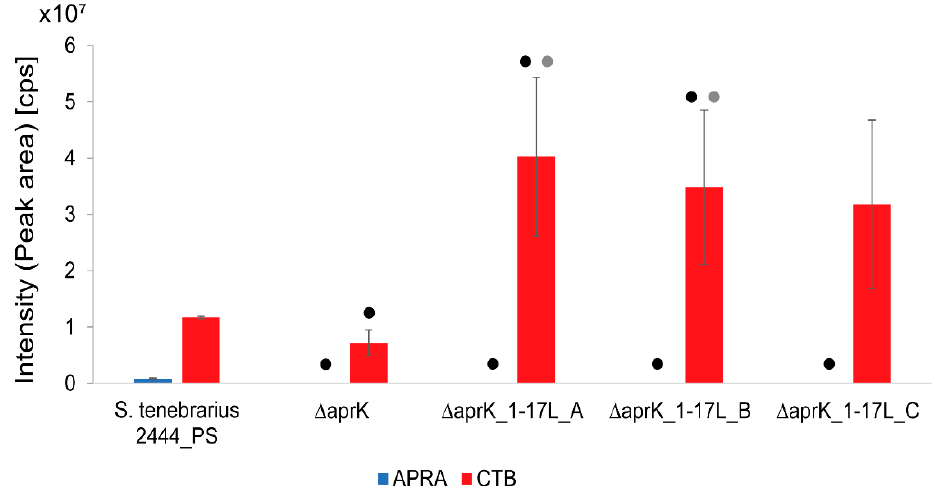
Figure 6. Apramycin (APRA) and carbamoyltobramycin (CTB) production in the Streptoalloteichus tenebrarius 2444 PS, the ∆ aprK mutant, and the ∆ aprK mutant containing an additional copy of the tobramycin BGC (triplicates for three isolates of ∆ aprK _1-17L, A – C ). The production assay was conducted in M11 medium. cps, counts per second (the number of ions that hit the detector per unit of time). The bars represent the means of triplicates (3 independent biological replicates), and the error bars represent the standard deviation (SD). The hypotheses H0 and H1 as well as the p -values of the Student’s t -test are included in Supplementary Materials Table S9. The results with p -values < 0.05 (each sample compared with S. tenebrarius 2444 PS) are marked with a black dot. The results with p -values < 0.05 (each sample compared with the ∆ aprK mutant) are marked with a grey dot.